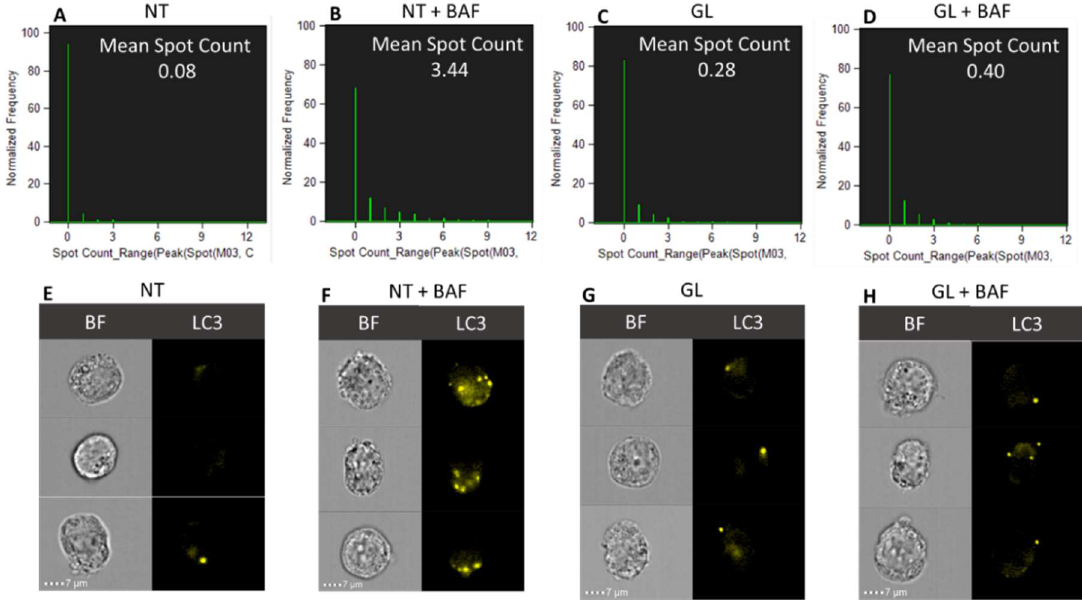
Figure 6. LC3-II spot-count histograms and cells galleries. The spot-count feature Spot Count_Range(Peak(Spot(M03,Ch3-LC3-AF555,Bright,7,3),Ch3,Bright,0) was used for NT ( A ), NT + BAF ( B ), GL ( C ), and GL + BAF ( D ). The mean spot counts for NT, NT + BAF, GL, and GL + BAF are 0.08, 3.44, 0.28, and 0.40, respectively. Brightfield (BF) and LC3-AF555 (yellow) images of the cells